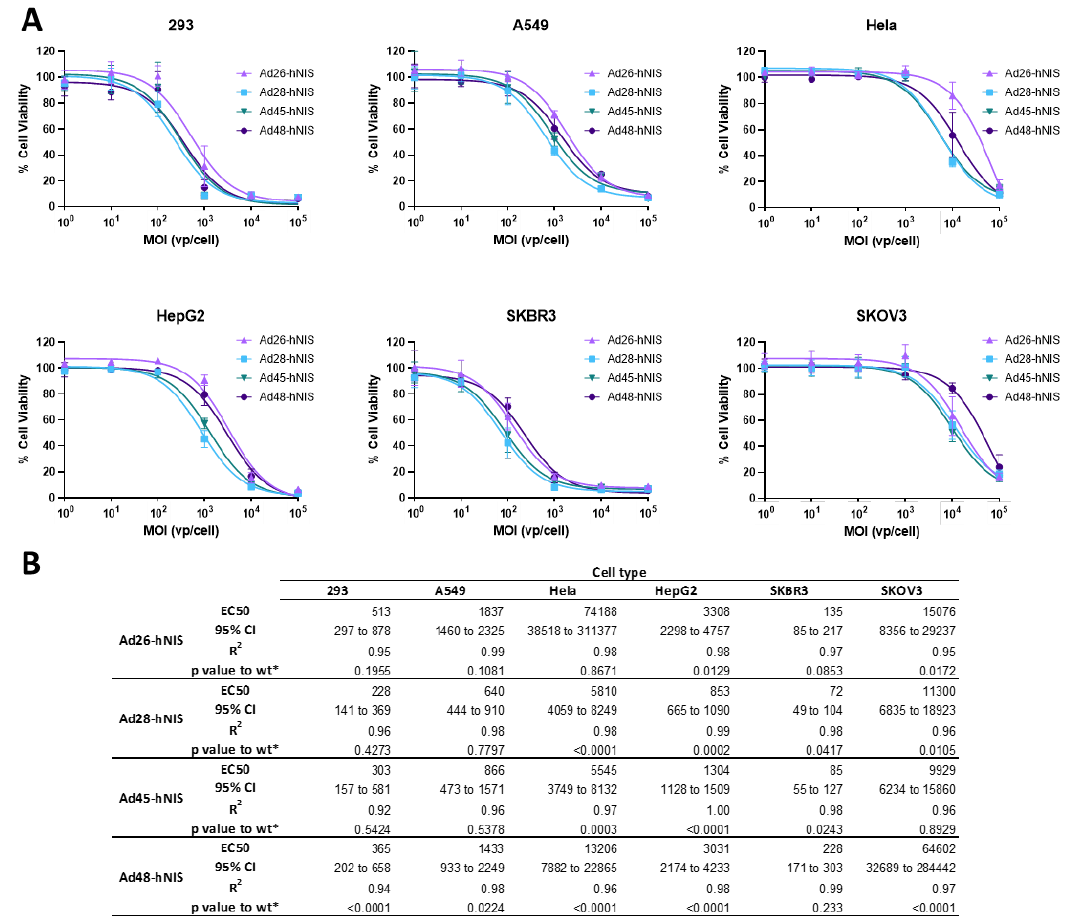
Figure 6. Oncolytic activity of each recombinant species D Ad-hNIS virus. ( A ) The half maximal effective concentration (EC50) of the four species D Ad-hNIS viruses was determined by infecting cells with serial dilutions of the indicated virus and evaluating cell death 5 days post infection by an MTT assay. Cell viability was determined by comparison to uninfected cell controls. Data is presented as mean ± standard deviation (SD) from three independent experiments. ( B ) Table of EC50s, 95% confidence intervals, R 2 values, and p value of the Ad-hNIS EC50 curve compared to the wildtype EC50 curve.